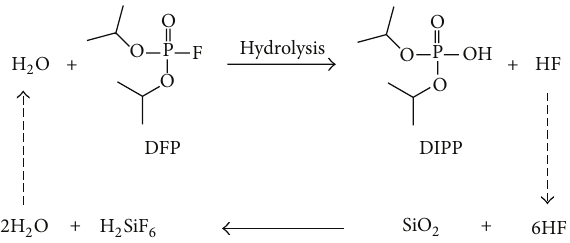
Figure 9: Autocatalytic hydrolysis of DFP when stored in glass